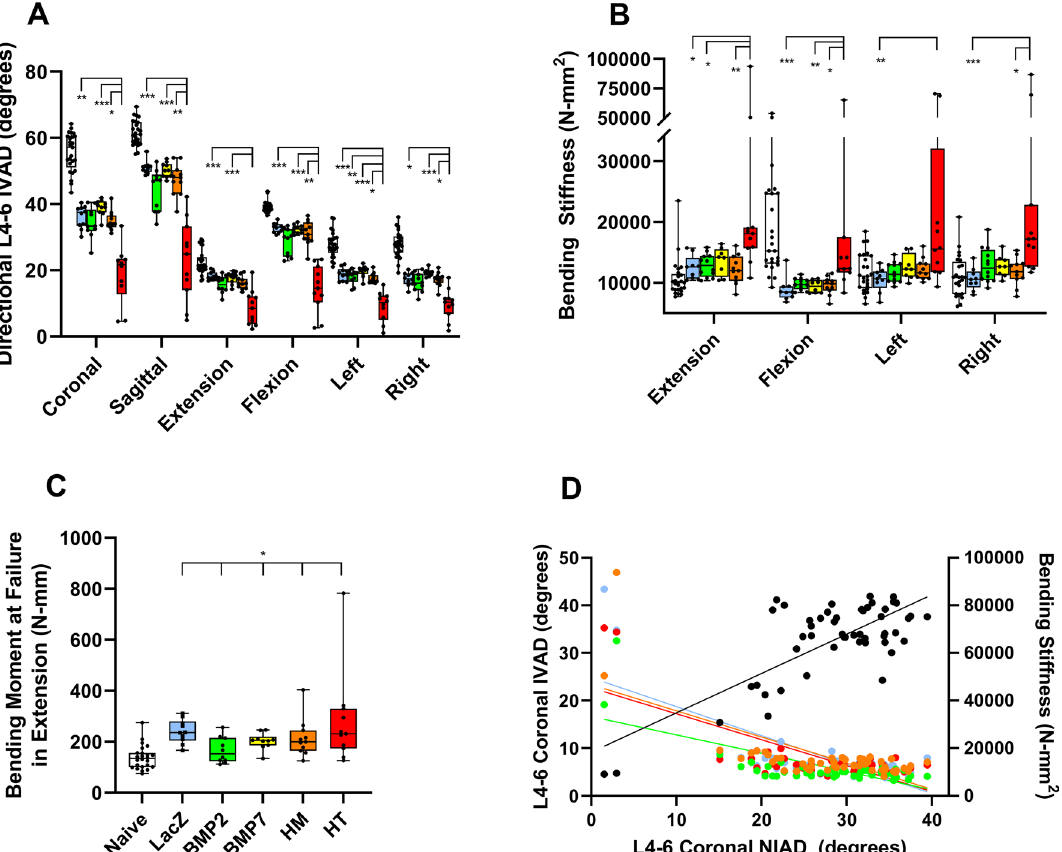
Figure 2. In vitro angular displacement (IVAD) ( A ) and four-point bending ( B ) assessments showed greatest stiffness induction in BMP2/7 heterodimer (HT) treated spines. Spines were assessed for IVAD and four-point bending over the combined lumbar segment 4–6 (L4-6) at 12 weeks after intradiscal delivery of genetically programmed bone marrow stromal cells. The bending moment at failure in extension ( C ) showed a treatment effect, but post-hoc testing did not reveal a unique treatment. In ( A )–( C ) treatments correspond to color (white square is Naïve, blue square is LACZ, green square is BMP2, yellow square is BMP7, orange square is mixed BMP2 and BMP7 [homodimers, HM], red square is BMP2/7 [heterodimers, HT]). Individual data points are shown, box plots represent treatment-group median, 25th and 75th percentiles and whiskers denote minimum and maximum data points. Significance: p ≤ 0.001 (***), p ≤ 0.01 (**), and p ≤ 0.05 (*). ( D ) scatter plot of paired IVAD:NIAD (black circle) and NIAD:four-point bending stiffness (orange circle is extension, green circle is flexion, red circle is right bend, and light blue circle is left bend). Note that the infrequently observed double- level fusions represent the low NIAD value specimens on the left side of the bending stiffness testing had inter-group treatment effects in each direction with only HT samples having inter- group differences (Fig. 2B). Load to failure in extension was affected by treatment, but post-hoc testing did not identify a uniquely different treatment (Fig. 2C). Failure location was dictated by the fusion status of the samples in the HT group, and all non-fused samples had an increased frequency of failure at the L5/6 level (32 out of 42, p < 0.001 with 95%CI [60.55, 87.95]). Significant correlation ( p < 0.001 for each) was noted in 4 directions between IVAD and four-point stiffness, with Pearson’s r = − 0.607 in extension, r = − 0.672 in flexion, r = -0.712 in left bending, and r = -0.655 in right bending. Similarly, L4-6 (coronal) NIAD correlated ( p < 0.001 for each) with four-point biomechanics in extension (r = − 0.692), flexion (r = − 0.690), left bending (r = − 0.735) and right bending (r = − 0.727), whereas correlation with failure moment in extension was significant ( p = 0.005) but weaker (r = − 0.385) (Fig. 2D). BMP HT treatment resulted in an increased frequency of spinal fusion assessed at 12 weeks by manual palpation and radiography. Fusion assessed by palpation at L4/5 occurred in 69% of HT spines, and at one or both levels of HT spines 94% of the time (15/16). At L4/5 HT treatment resulted in fusion more frequently than in any other treatment ( p = 0.006), and no other comparative intergroup treatment effects were observed ( p = 1). Palpation at L5/6 also revealed that HT (7/16 or 31%) outperformed all other groups (1/62 or 2%) ( p < 0.001), but post-hoc pairwise testing did not identify intergroup differences after Bonferroni correction ( p = 0.37) (Table 4). Palpation-assessed fusion for the entire population was not different at L4/5 (12/78) than at L5/6 (8/78) ( p = 0.47), and palpation-assessed fusion success was not different by level for the HT-treated group ( p = 0.28). Categorical radiographic fusion also occurred most frequently in HT as compared to all other groups